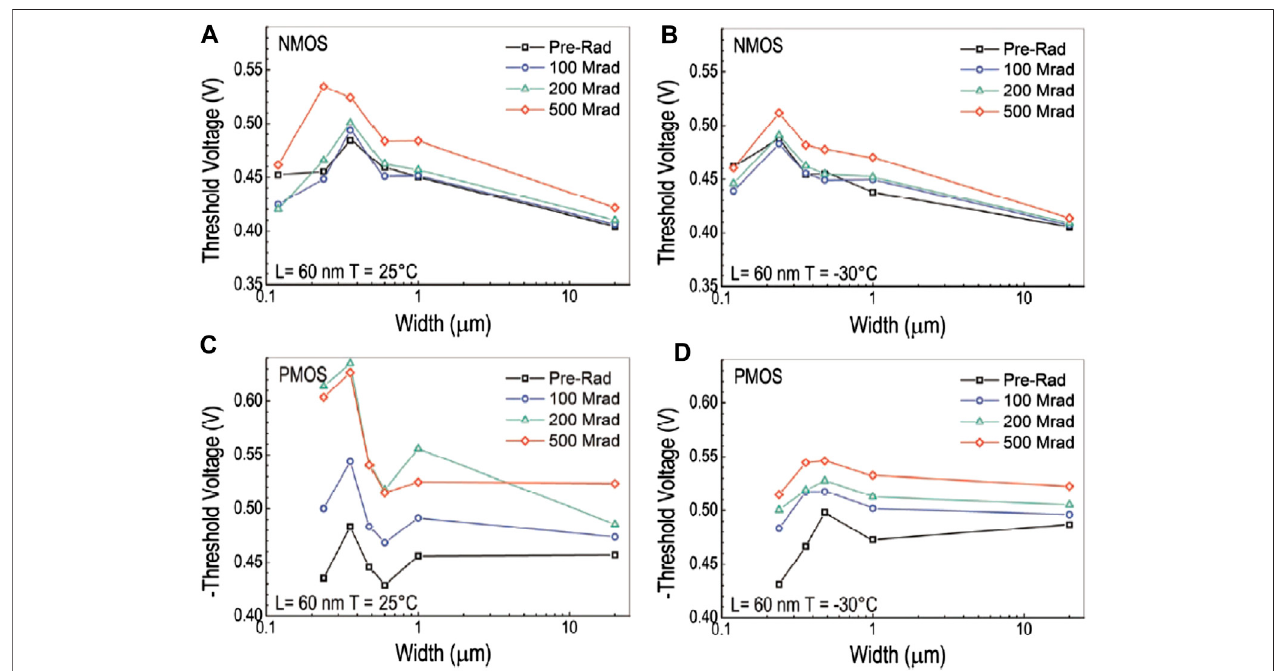
FIGURE 2| Threshold voltage vs. channel width in saturation mode for short nMOS (A , B) and pMOS (C , D) at room (A , C) and low (B , D) temperaturesfor different total dose irradiation From [6].